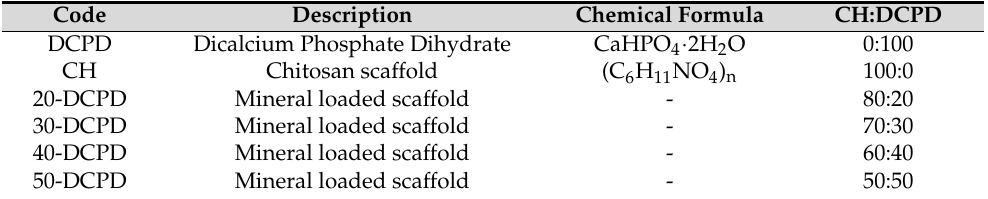
Table 1. The synthesised Dicalcium Phosphate Dihydrate mineral and freeze-dried scaffolds with corresponding code